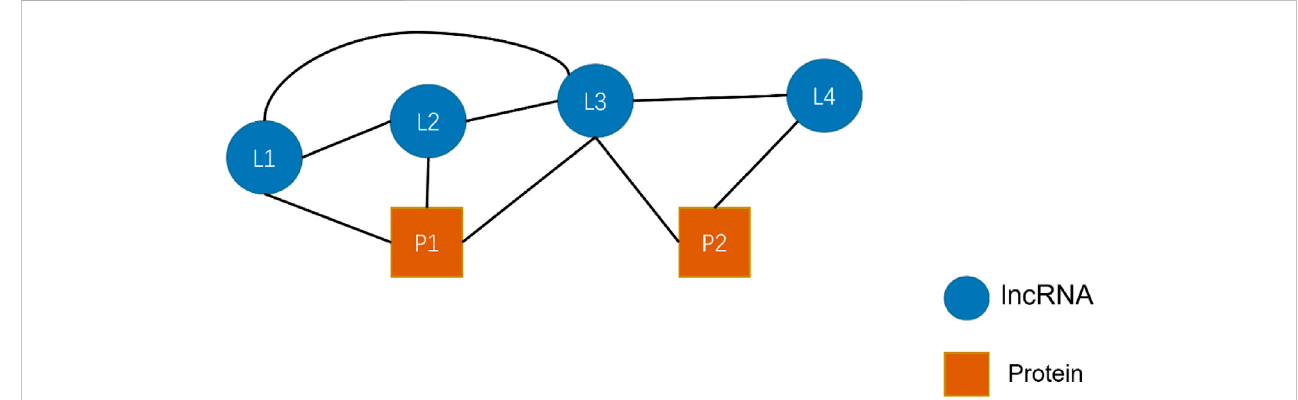
FIGURE 7 An example of a simple heterogeneous network of lncRNA-protein interactions.